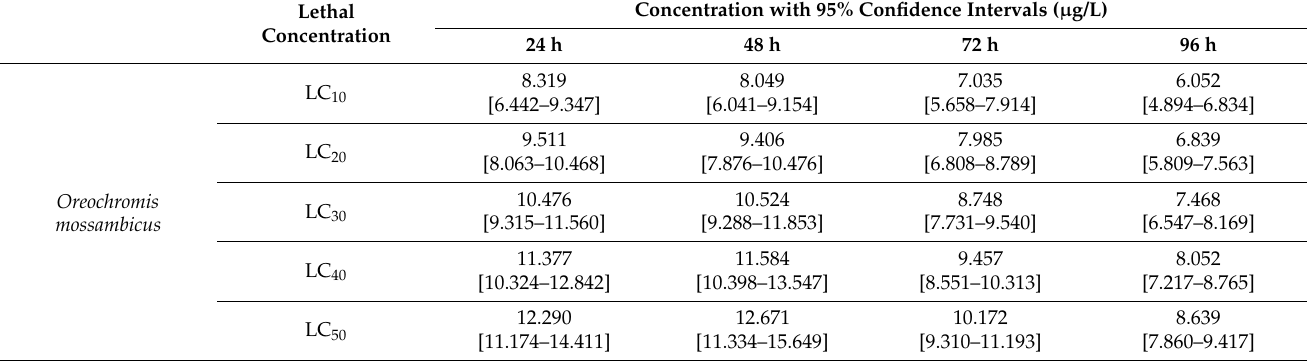
Table 1. Lethal concentrations (LC 10, 20, 50 ) plus 95% fiducial limits [given in square brackets] of deltamethrin to O. mossambicus at 24 h–96 h exposure (ten fish per aquarium, forty fish per exposure group; four